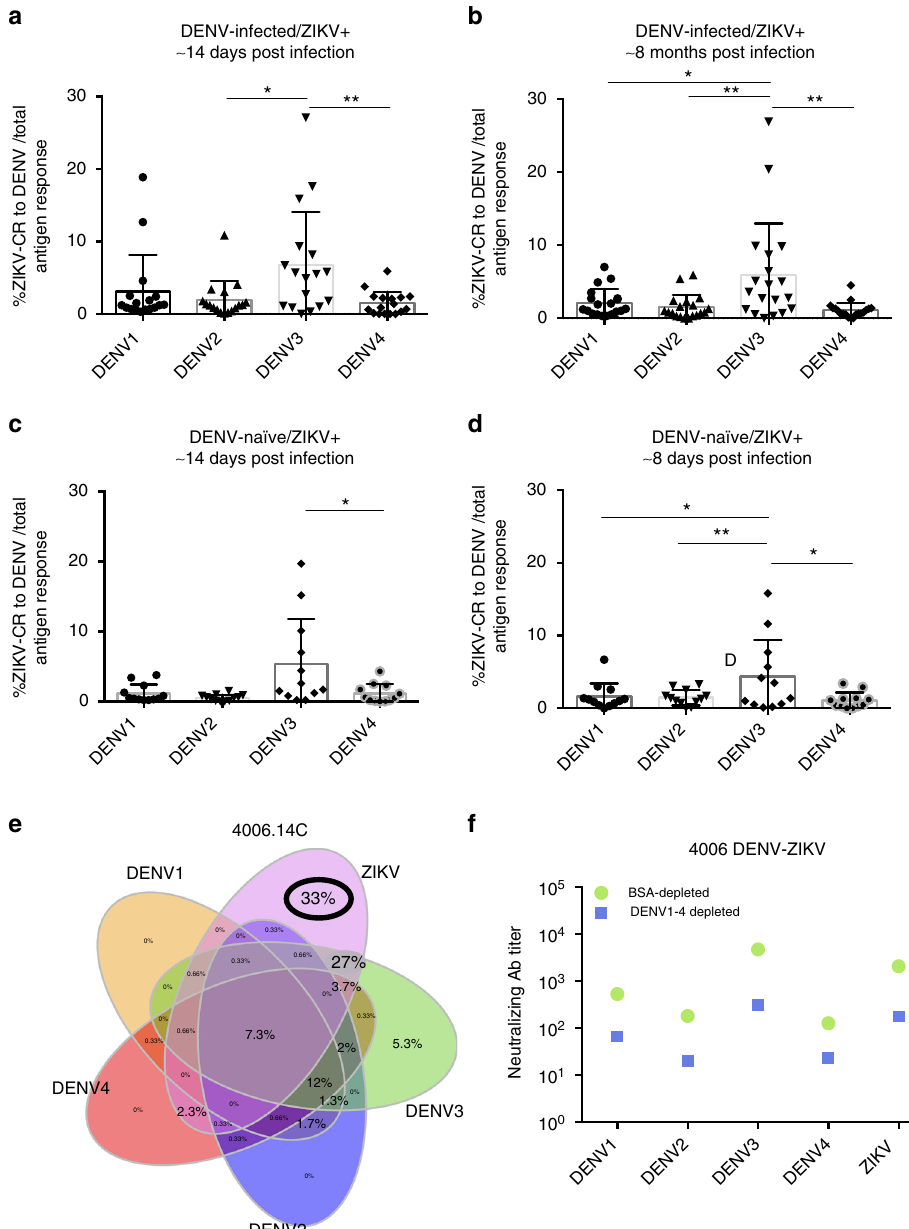
Fig. 7 ZIKV infection displays highest cross-reactivity to DENV3. The MBC cross-reactivity between ZIKV and DENV was analyzed for each DENV serotype individually. The analysis was performed in the DENV-naïve/ZIKV + and DENV-infected/ZIKV + groups. a , b Proportion of ZIKV cross-reactivity to DENV serotypes in DENV-infected/ZIKV + individuals at ~14 days ( a ) and ~8 months ( b ) post-ZIKV infection. c , d Proportion of ZIKV cross-reactivity to DENV serotypes in DENV-naïve/ZIKV + patients at ~14 days ( c ) and ~8 months ( d ) post-ZIKV infection. e Venn diagrams of type-speci fi c and cross-reactive responses to ZIKV and DENV in MBCs of activated PBMCs from patient 4006 at ~8 months post-ZIKV infection. f DENV-depleted and nondepleted (BSA control) serum responses from patient 4006 at ~8 months post-ZIKV infection. The median and IQR are shown for a – d . Signi fi cance was determined by ordinary one-way Anova Multiple Comparison. * p < 0.05, ** p < 0.01, *** p < 0.001. DENV-naïve/ZIKV + , n = 12; DENV-infected/ZIKV + , n